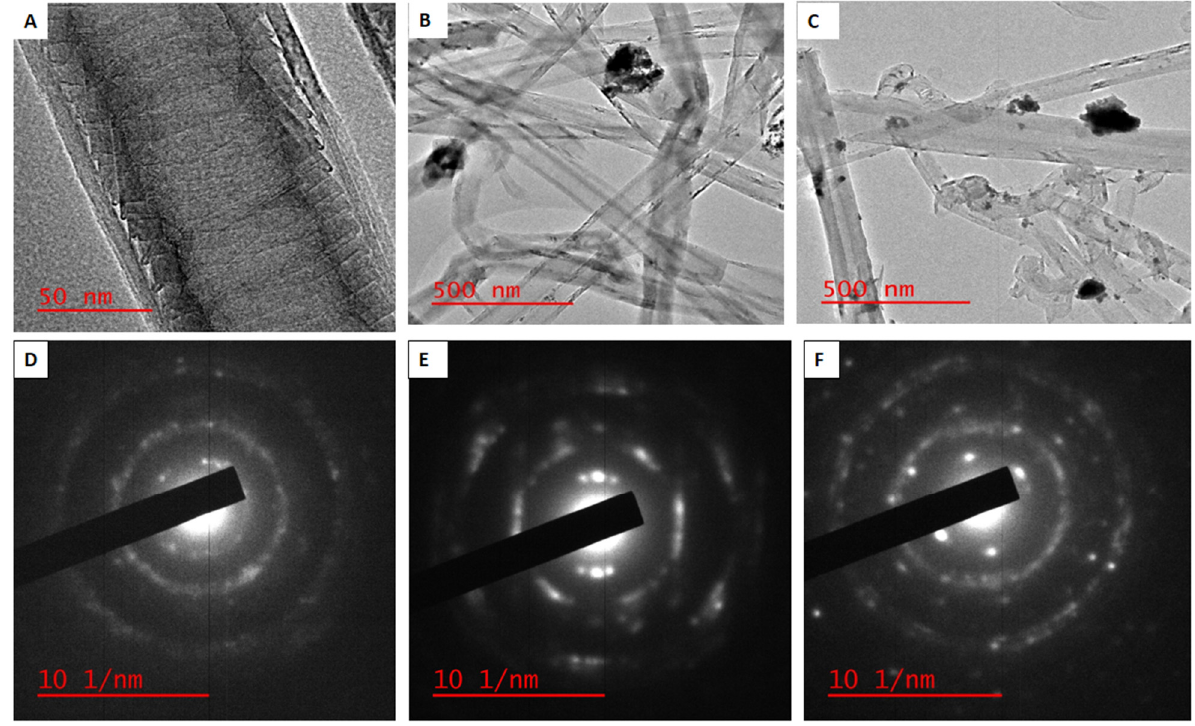
Figure 1. HRTEM images of CNFs ( A ), Pd/CNFs ( B ) and Pd-Sn/CNFs ( C ) electro-catalysts; SAED patterns of CNFs ( D ), Pd/CNFs ( E ) and Pd-Sn/CNFs ( F ) electro-catalysts.